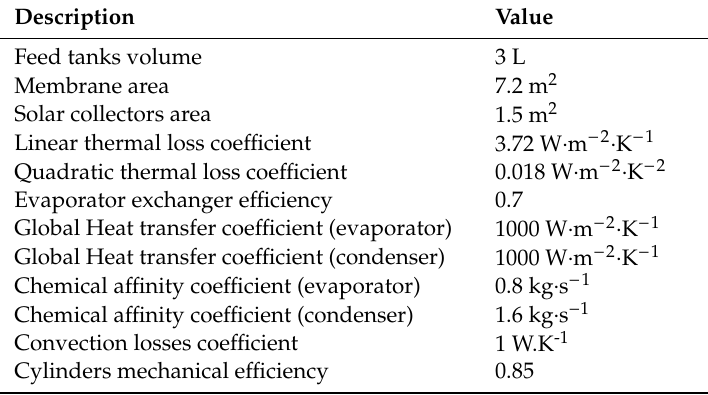
Table 4. Component sizes of the process and simulation parameters.